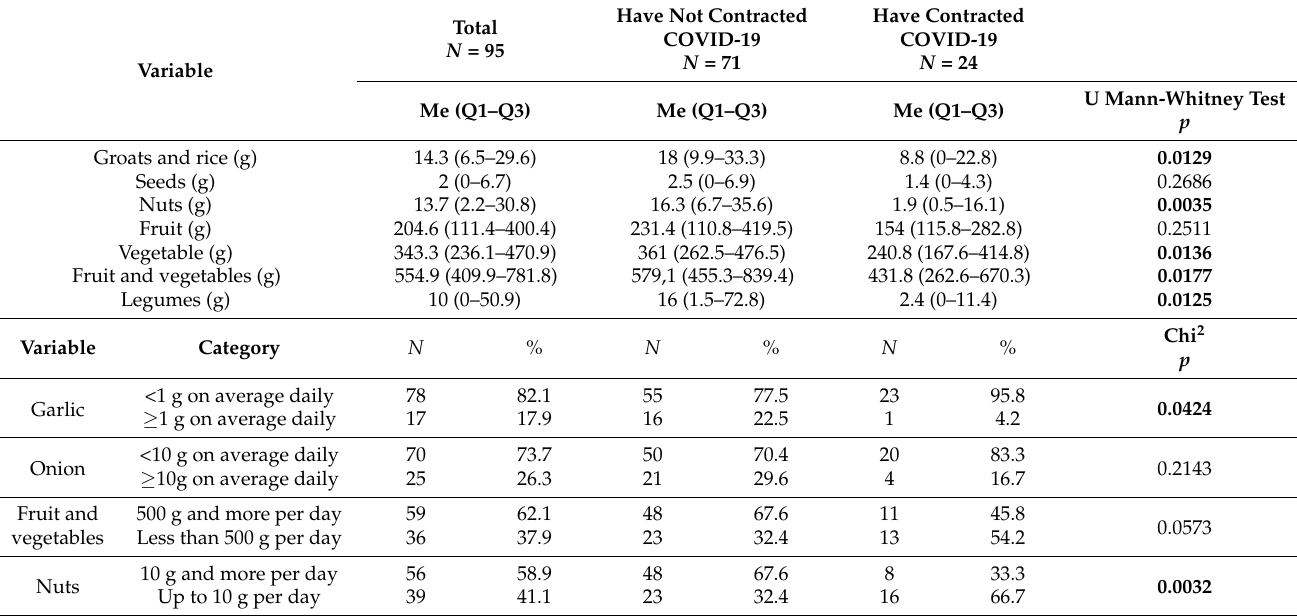
Table 4. Consumption of selected food products by the